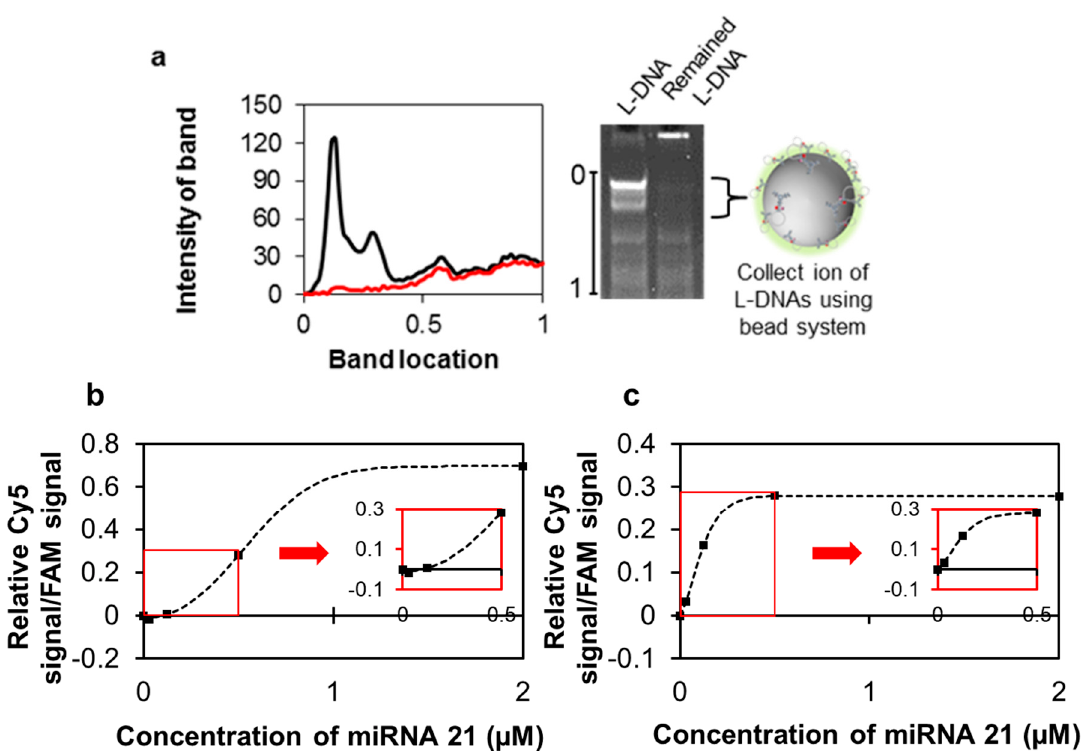
Figure 5. Construction of a bead-immobilized molecular beacon-equipped DNA nanosensor and its detection efficiency. ( a ) 15% PAGE image of the molecular-beacon-equipped DNA nanosensor (L-DNA) and the rest of L-DNAs. L-DNA was collected by 110 nm-sized PS beads via avidin–biotin conjugate chemistry. Red and black lines indicate L-DNAs and remaining L-DNAs, respectively. Minimum profile was used as a background signal; the purity of L-DNA increased from 58.4 to 86.8% when a solid support was used. ( b ) Detection efficiencies of free L-DNA and ( c ) the bead-immobilized L-DNA nanosensor system were compared. All data collected were obtained from triplicate experiments. The miRNA 21 was used at concentrations of 2, 0.5, 0.125, 0.03125, and used 0 µ M as a negative